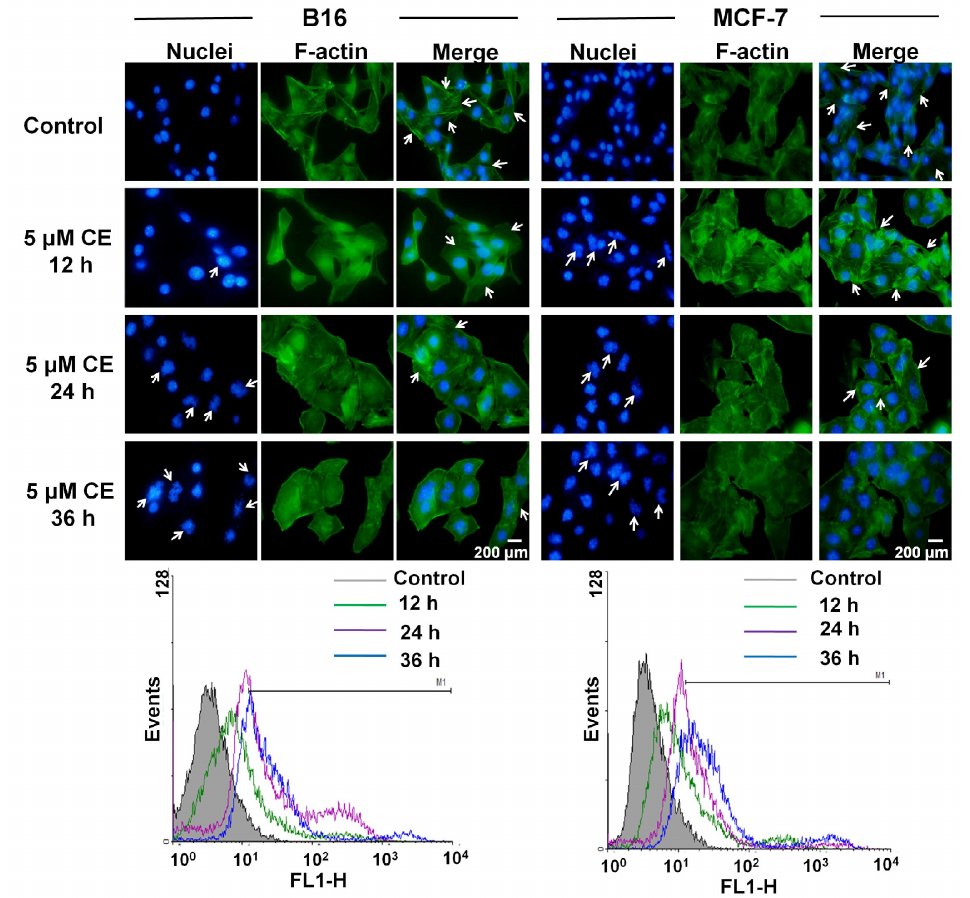
Figure 7. Alterations of microfilaments cytoskeleton caused by CE on B16 and MCF-7 cells ( n = 3). The blue color indicated the location of nuclei and the green color indicated the location of F-actin. The white arrows indicate the formation of apoptosis body or stress fibers of F-actin. Scale bar, 200